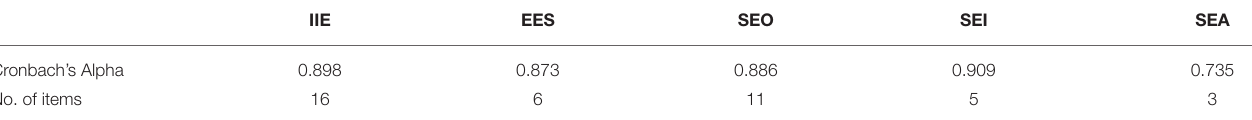
SEIPP SEITL SEITS SEIDT SEIRD SEI_TOT Pearson Cor. SEAP SEAIM SEAII SEA_TOT Pearson Cor.